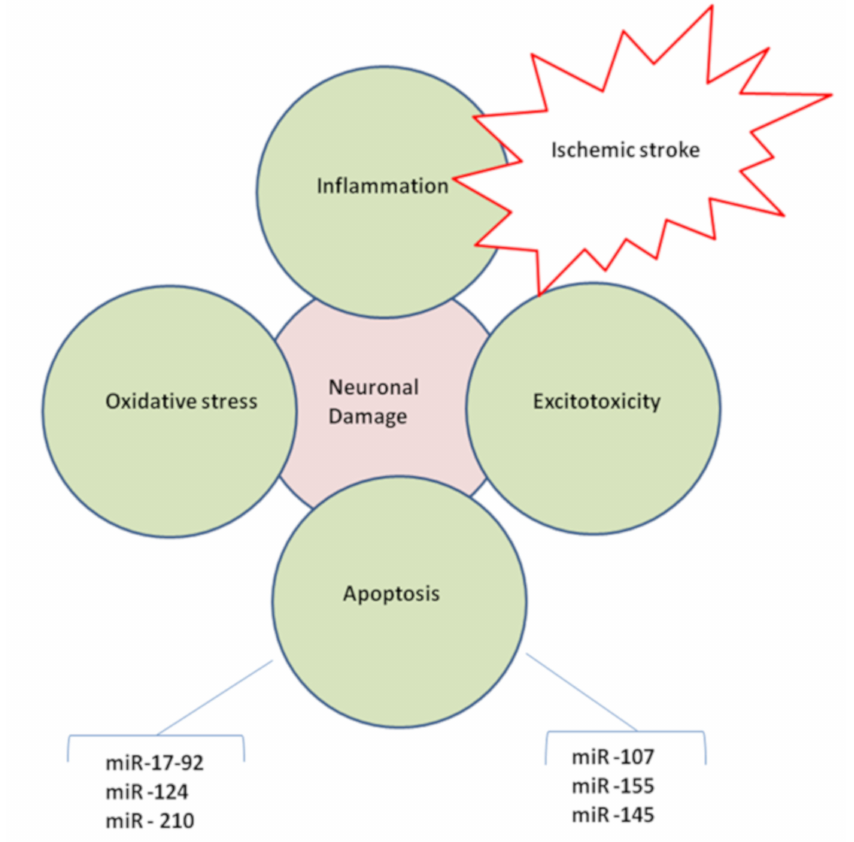
Figure 2. Cerebral ischemia accompanying pathogenic mechanisms viz., inflammation, oxidative stress, apoptosis, and excitotoxicity, which contribute to the neuronal damage during ischemic stroke. Potential therapeutic arenas for mitigating these pathophysiological processes could be stimulation of angiogenesis and neurogenesis through miRNA